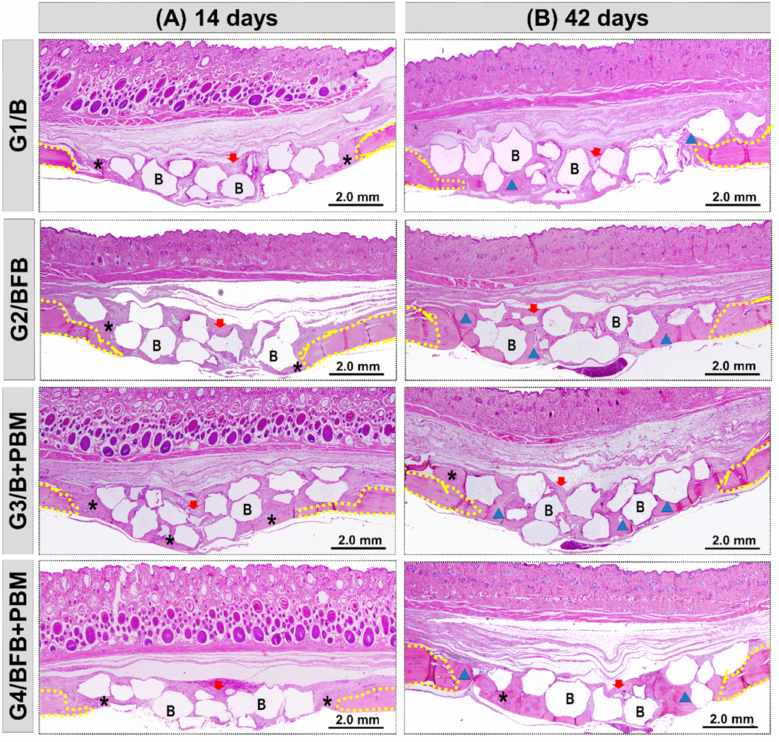
Figure 6. Panoramic histological views at 14 ( A ) and 42 ( B ) days in the cranial defects filled with bio- material (G1/B), biocomplex consisting of biomaterial plus heterologous fibrin biopolymer (G2/BFB), biomaterial and PBM (G3/B + PBM), and biocomplex consisting of biomaterial plus heterologous fibrin biopolymer and photobiomodulation with low-level laser therapy (G4/BFB + PBM). Imma- ture trabecular formation (asterisk) occurring at the edge of the defect (dashed line) and overlying the dura mater surface. Biomaterial particles ( B ) permeating the reaction connective tissue (red arrow). The transition from bone maturation to mineralized tissue (triangle), with primary bone areas (asterisk) and biomaterial particles in densely fibrous connective tissue (red arrow). HE; original magnification × 4; bar = 2